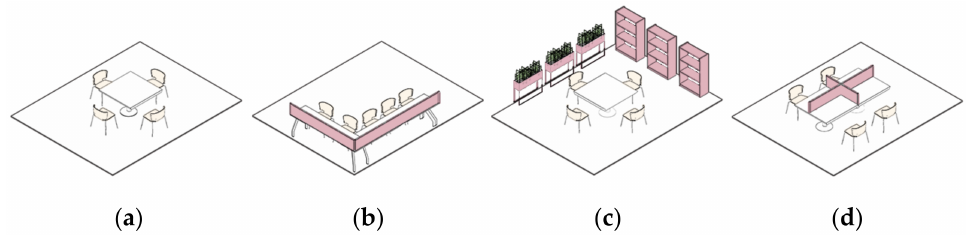
Figure 12. Strategy map to improve privacy: ( a ) original seats; ( b ) inward-facing L-shaped seats; ( c ) greenery to isolate the view; and ( d ) desktop partitions to isolate the